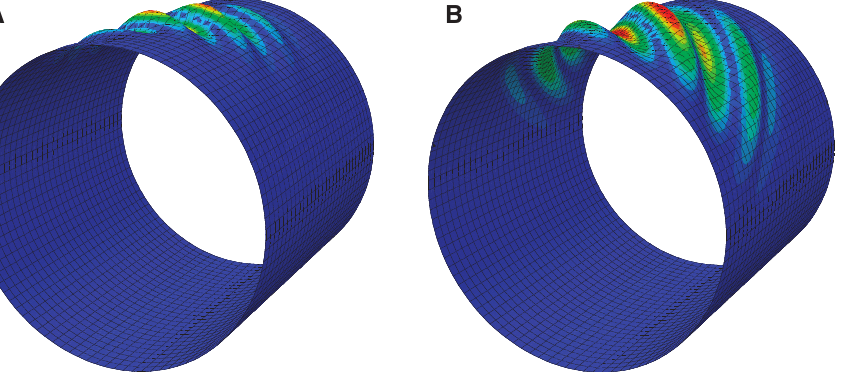
Figure 4: The buckling mode of the composite cylinder with (A) QI and (B) VS laminate with 25% of layers considered for fiber steering (case 2).